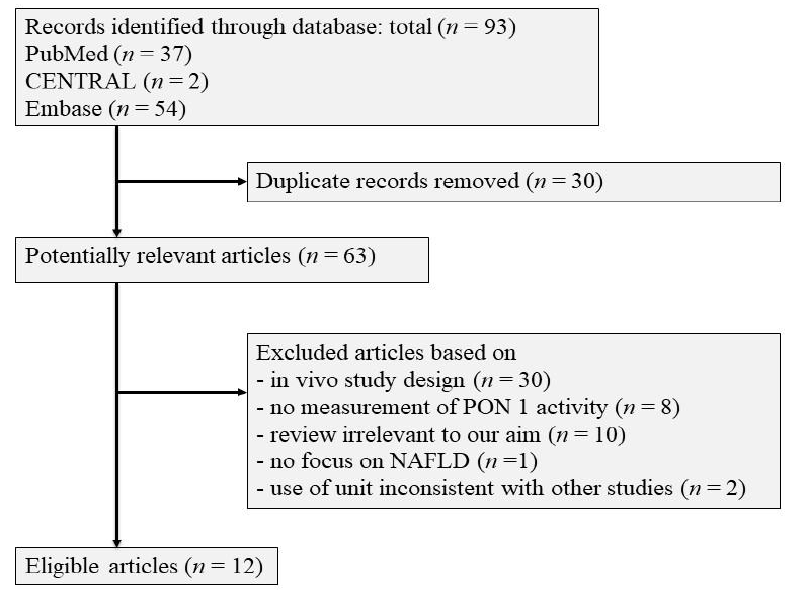
Figure 4. Flow chart of the selection of eligible studies.